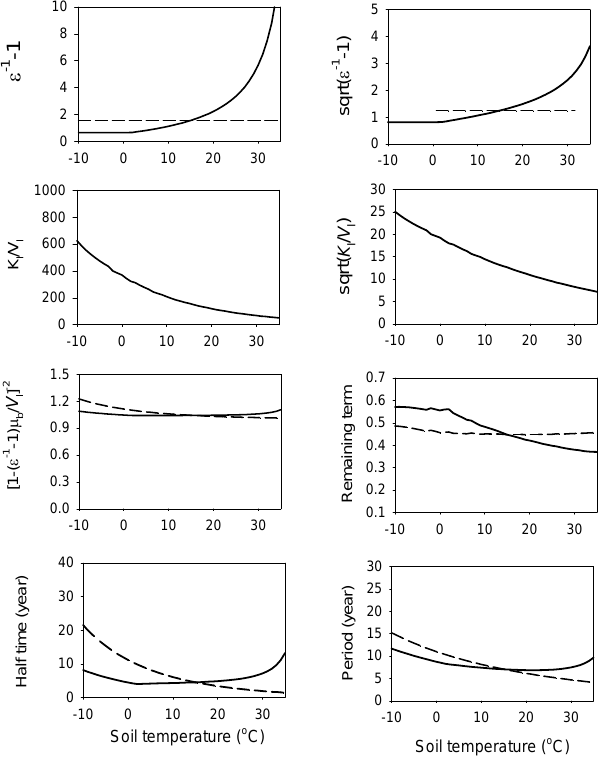
Fig. 6. Temperature dependence of different terms of t 0 . 5 or pe- Figure 6. Temperature dependence of different terms of the half-life time ( t 0.5 ) or period for the two 797 riod for the two oscillatory pools in the three-pool model. The oscillatory pools in the three-pool model. The solid and dashed curves represent the temperature 798 solid and dashed curves represent the temperature dependence with dependences with temperature-sensitive and temperature-insensitive microbial growth efficiency, 799 temperature-sensitive and temperature-insensitive microbial growth respectively. 800 efficiency, ) with x / x and soil temperature ( T 0.5 ks vs / x and T (lower panel) in the two-pool model. The unit is year for both t ks vs s